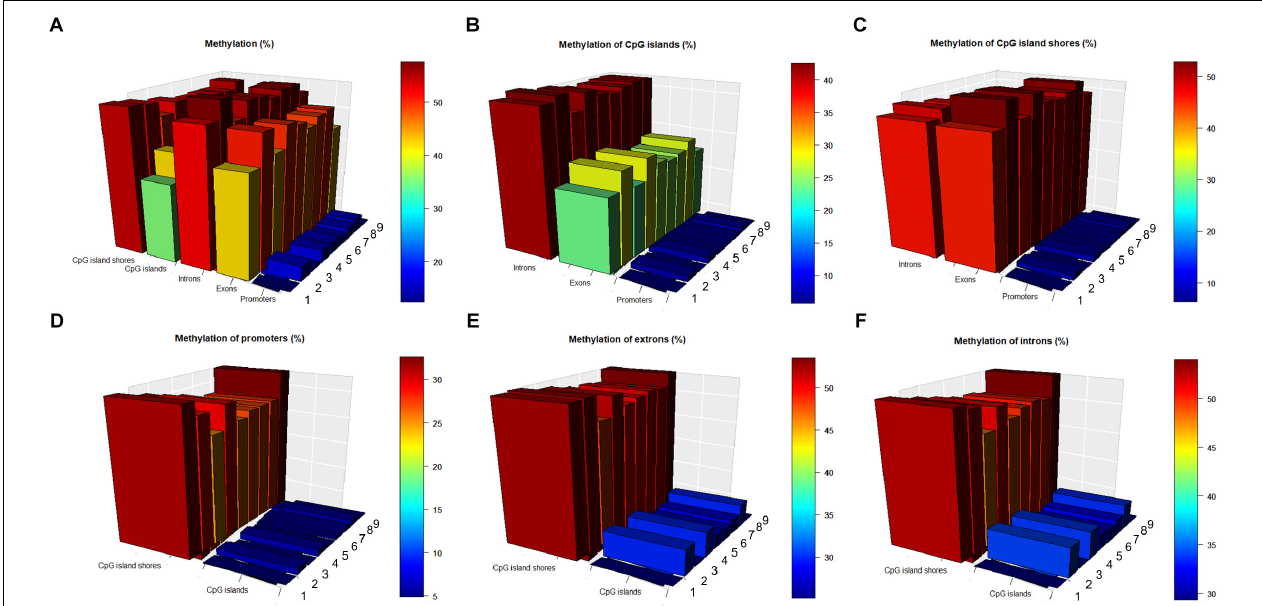
FIGURE 3 | Methylation patterns in different genic features and CpG islands regions. (A) Methylation levels (in %) at different genic features, CpG islands and CpG island shores. (B) Methylation levels (in %) of CpG islands at different genic features. (C) Methylation levels (in %) of CpG island shores at different genic features. (D) Methylation levels (in %) of promoters in the CpG islands and CpG island shores. (E) Methylation levels (in %) of exons in the CpG islands and CpG island shores. (F) Methylation levels (in %) of introns in the CpG islands and CpG island shores.